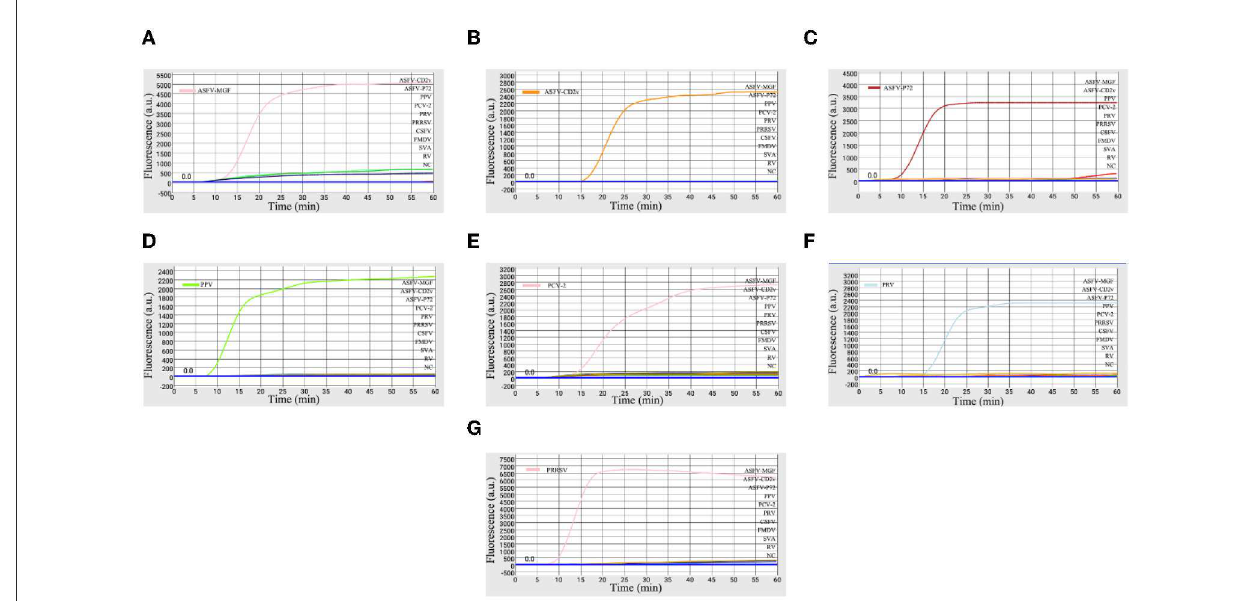
FIGURE3 Specificity of microfluidic-LAMP chip detection system. (A) Specificity analysis for primers targeting to ASFV- MGF505-2R ; (B) specificity analysis for primers targeting to ASFV- CD2v ; (C) specificity analysis for ASFV- P72 ; (D) specificity analysis for PPV; (E) specificity analysis for PCV-2; (F) specificity analysis for PRV; and (G) specificity analysis for PRRSV.